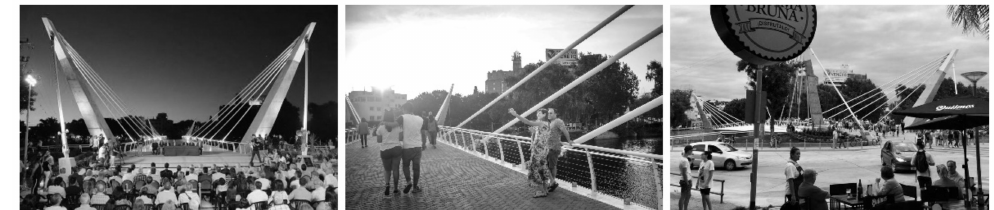
Figure 17. ( left ) Political promotion during the inauguration ceremony. ( center and right ) The bridge is used more as a public space. (Credit: Left: From public television broadcast (Cordoba Governance)).